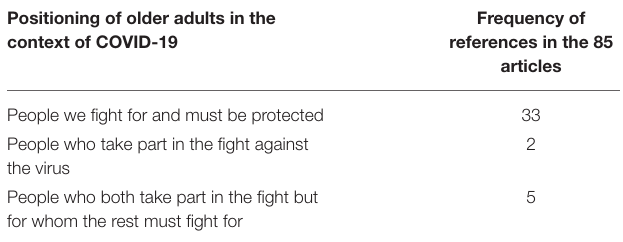
TABLE 3 | Positioning of older people during the pandemic. Positioning of older adults in the context of